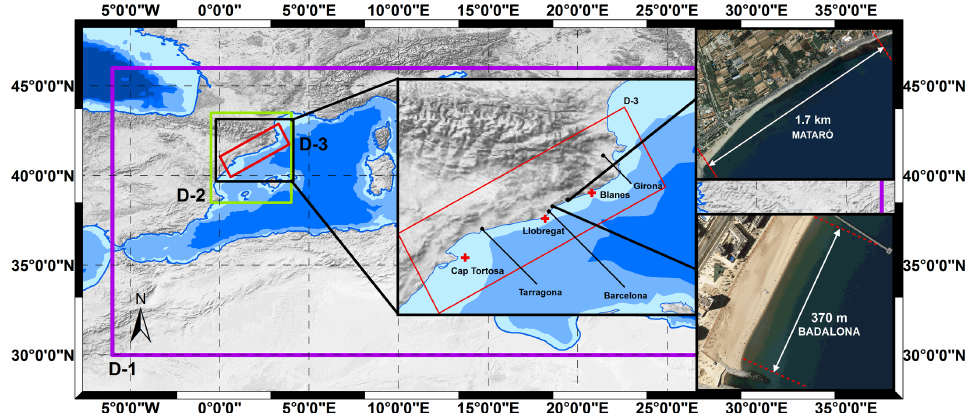
Figure 1. Western Mediterranean Sea and the three domains employed in the numerical simulations. The purple one represents the western Mediterranean Sea, the green one represents the Balearic Sea (D-2) and the red one the Catalan Coast Shelf (D-3). The red crosses denote the XIOM buoy positions. The two insets (Mataró and Badalona municipalities and beaches) correspond to the areas selected for morphodynamic